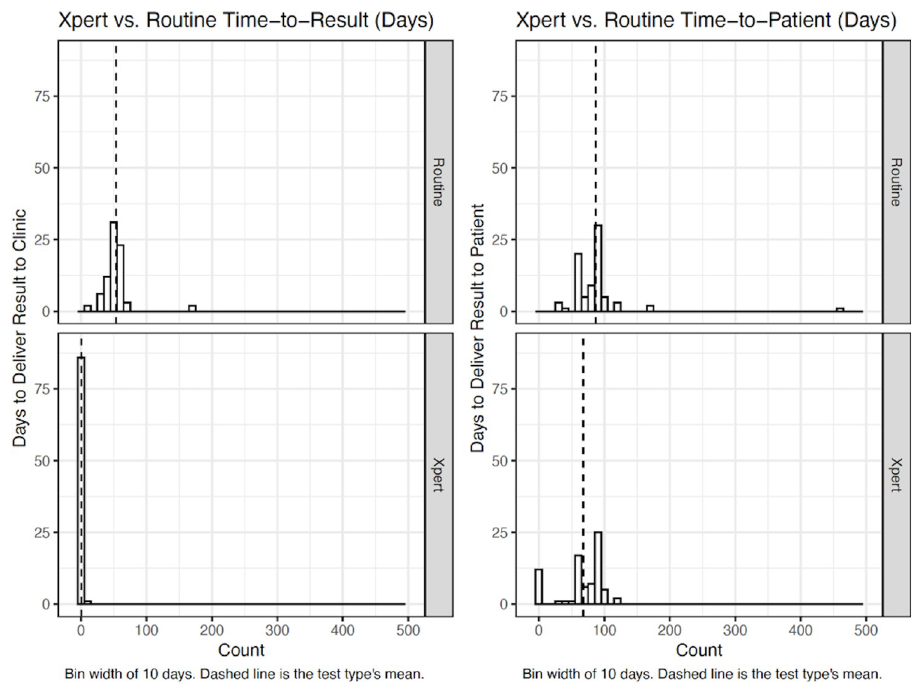
Fig 5. Histograms showing time-to-result and time-to-patient for each testing option.